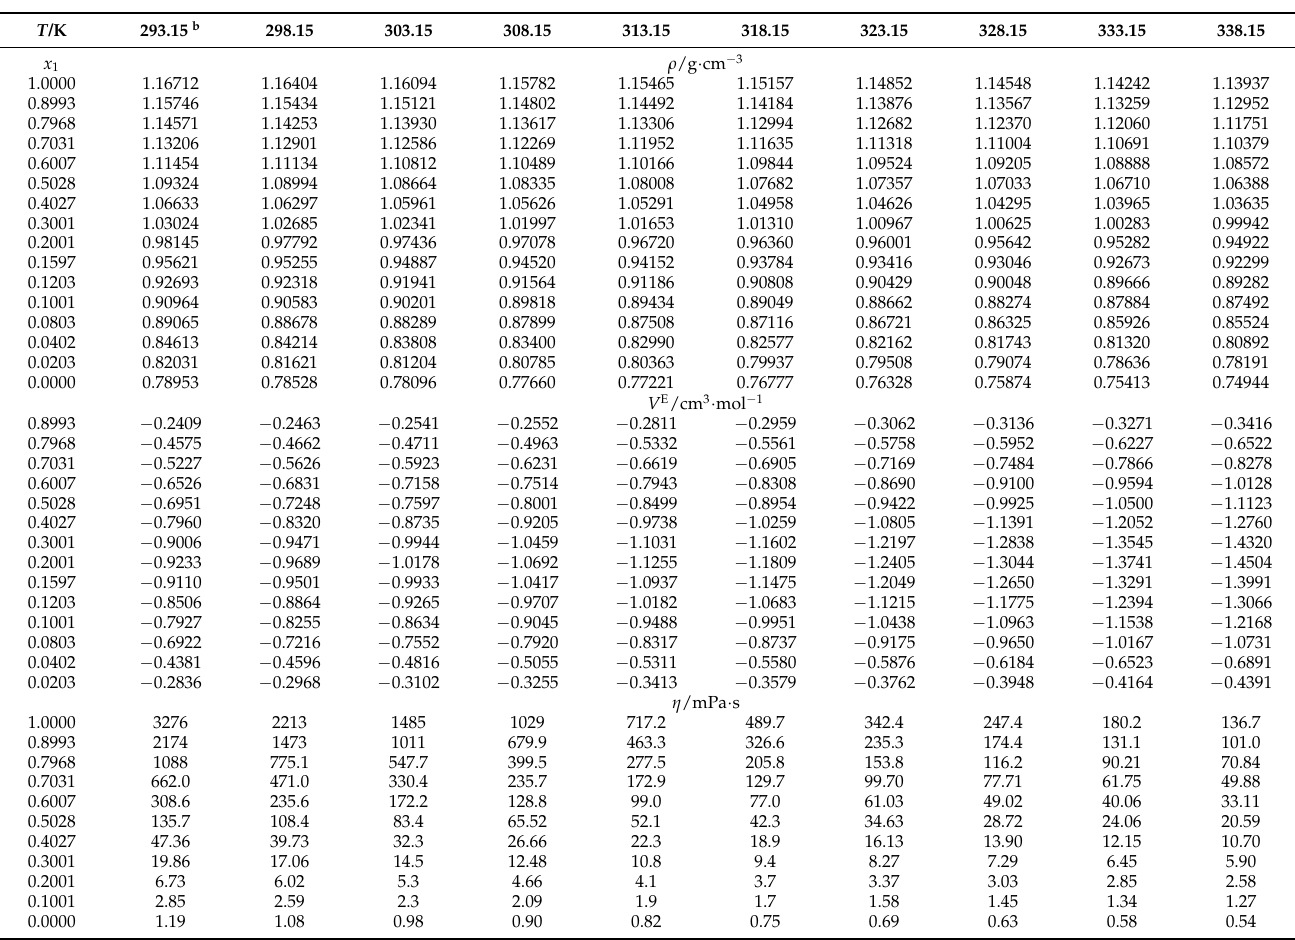
Table 7. Experimental values of density, ρ /g · cm − 3 , excess molar volume, V E /cm 3 · mol − 1 ,